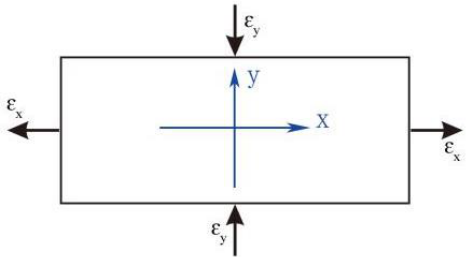
Figure 1. Exerting biaxial strain on the sample for deviatoric deformation: A tension is along x direction with ε x , and along y direction is a compression with ε y .